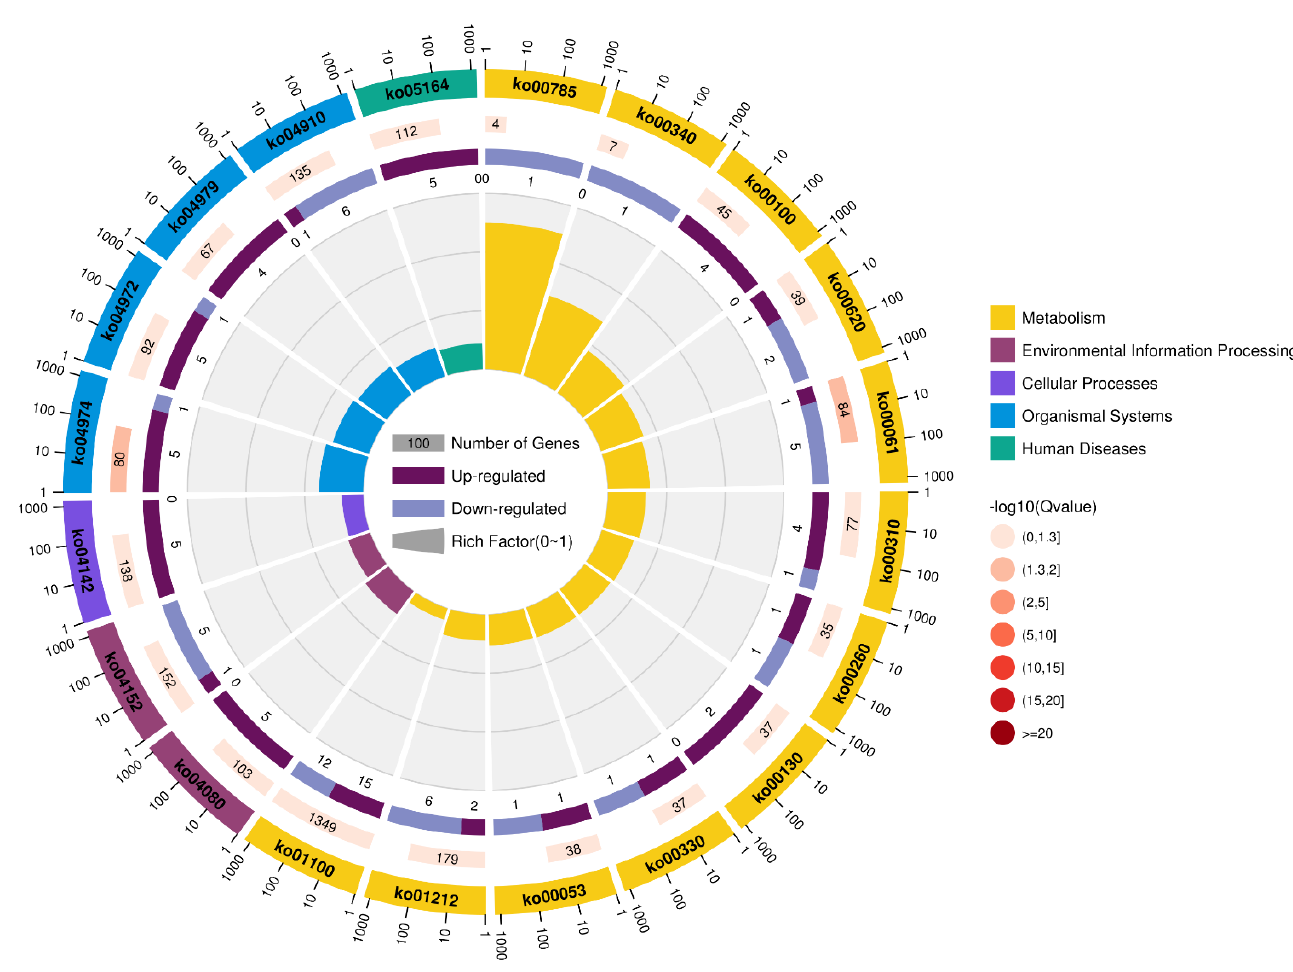
Figure 3. The most enhanced Kyoto Encyclopedia of Genes and Genomes (KEGG) pathways of S. invicta after indoxacarb exposure at sublethal concentrations (after 24 h). The significance of pathways is indicated by the q -value (color bar), the rich factor (X-axis), and the circle’s diameter, which indicates the number of genes regulated.